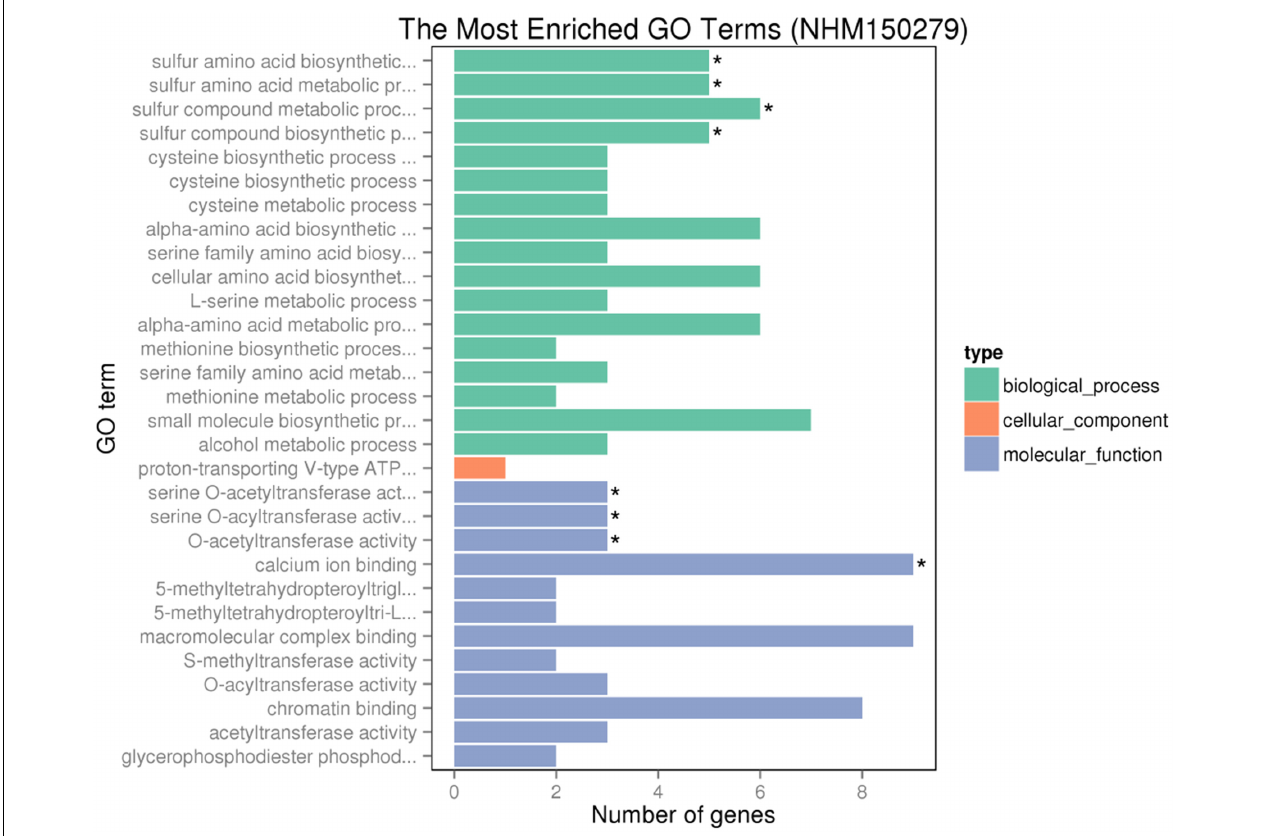
FIGURE 10 | GO analyses of 166 special DEGs after GR24 treatment under salinity stress. The DEGs were assigned into three groups with different colors, including BP, CCs, and MF. The x -axis represents the number of genes in each category, and y -axis represents the most abundant categories in each